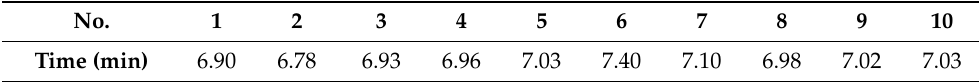
Table 5. Drip time of 500 mL IV saline bottle using smart IV dosing system.